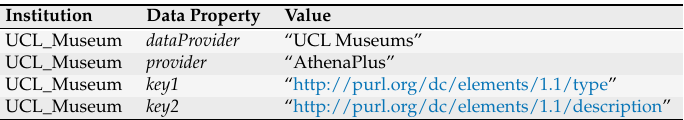
Table 1. Data properties of